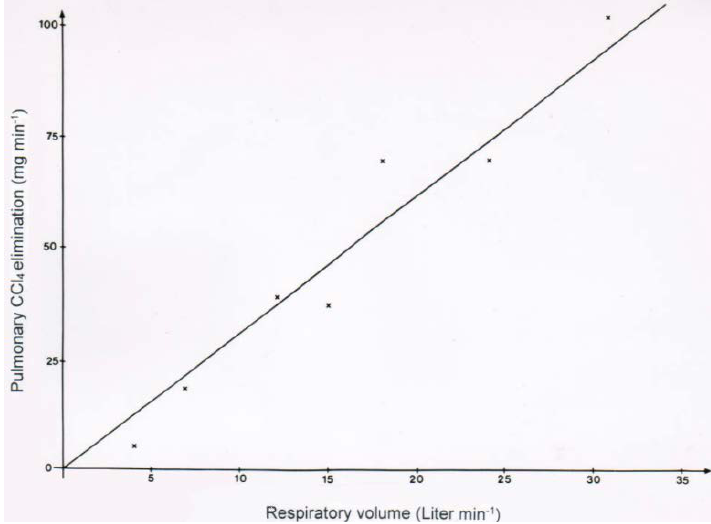
Figure 10. In a patient intoxicated by CCl 4 ingestion and treated with CO 2 -induced hyperventilation, CCl 4 disposal via the lungs was quantitatively assessed in relation to the respiratory minute volume, showing that the amount of CCl 4 eliminated is dependent on the respiratory minute volume achieved.